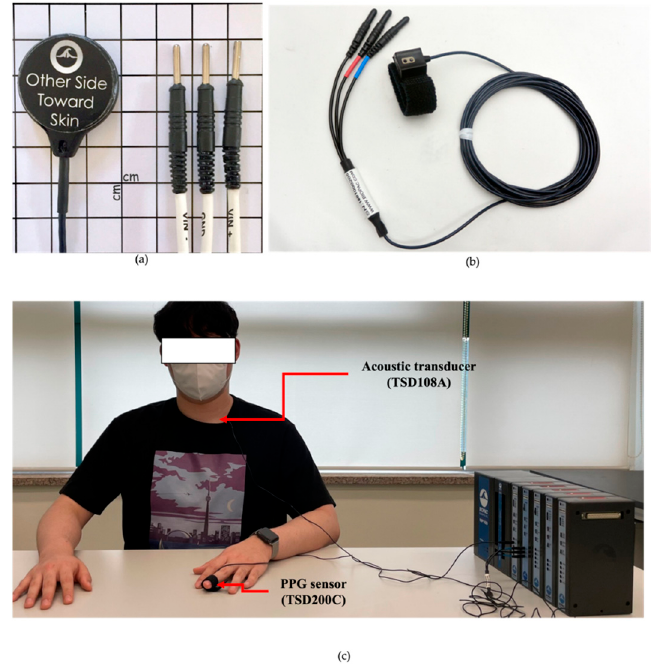
Figure 2. Pictures of experiment for data acquisition: ( a ) Acoustic transducer TSD108A (BIOPAC System, Inc., Goleta, CA, USA); ( b ) PPG sensor TSD200C (BIOPAC System, Inc., Goleta, CA, USA); ( c ) Experimental environment.